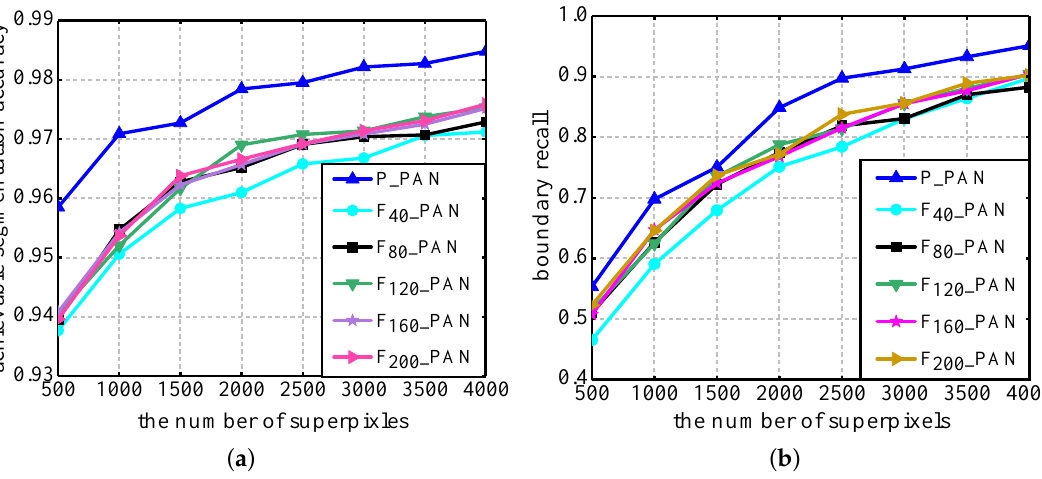
Figure 9. ( a ) The achievable segmentation accuracy under different iterations on Flevoland data set. ( b ) The boundary recall under different iterations on Flevoland data set. The subscript of F N _PAN represents